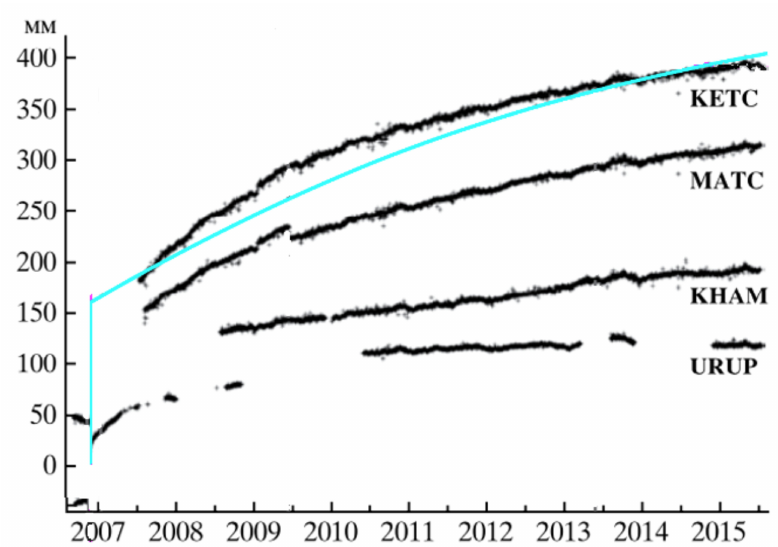
Figure 13. East-west displacement timeseries measured by Kuril GNSS network following the 2006–2007 Simushir earthquakes (black curves) and modeled displacement data (light blue line) calculated within the interior part of the rear block using the two-segment model. Positive values correspond to eastward (i.e., oceanward)